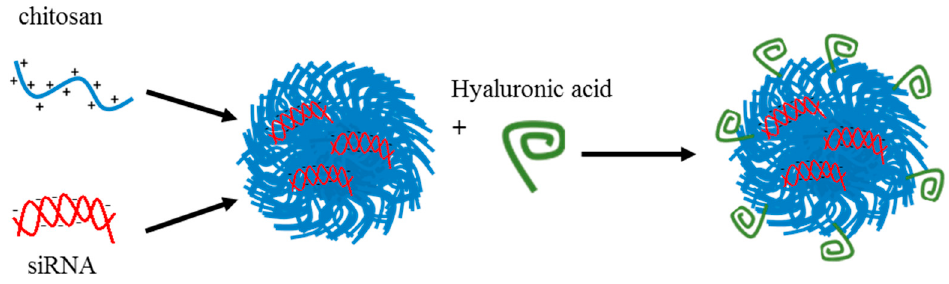
Figure 7. Polymeric delivery material developed in Reference [117].